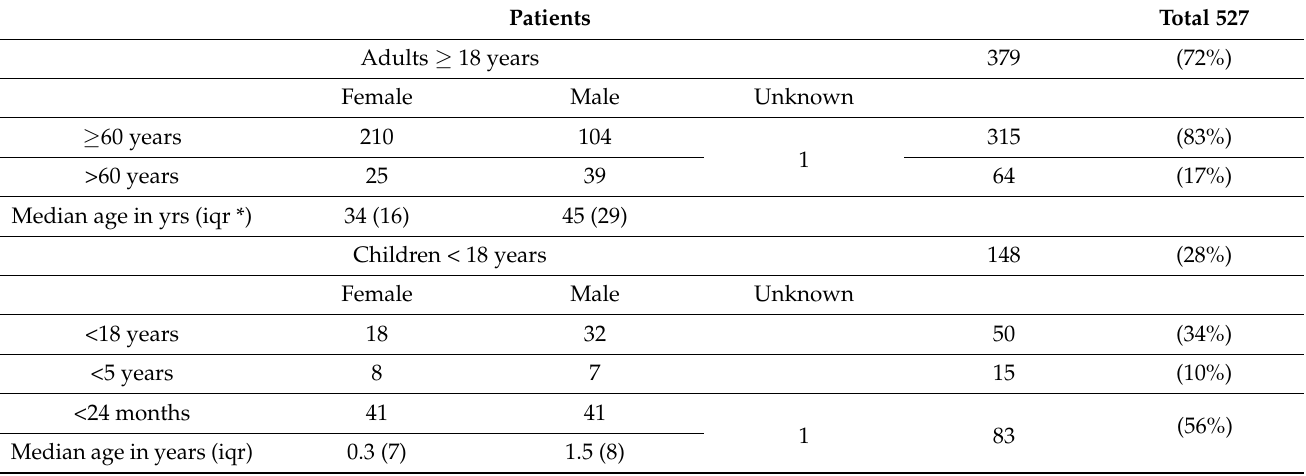
Table 2. Demographics of treated